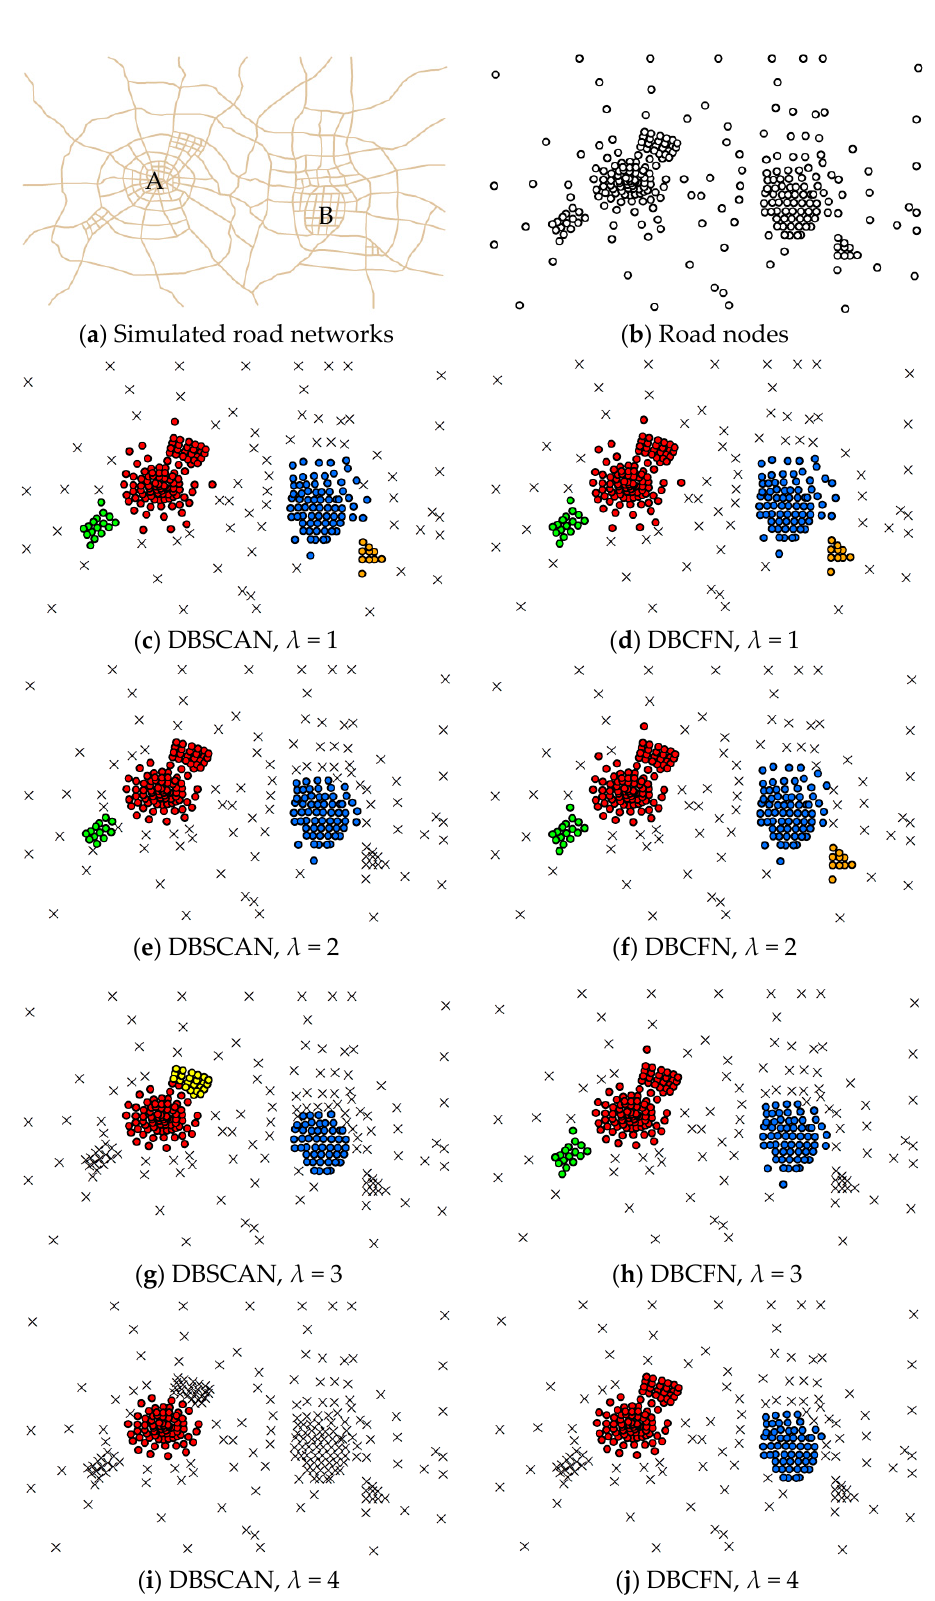
Figure 5. Simulated data and contrast results.